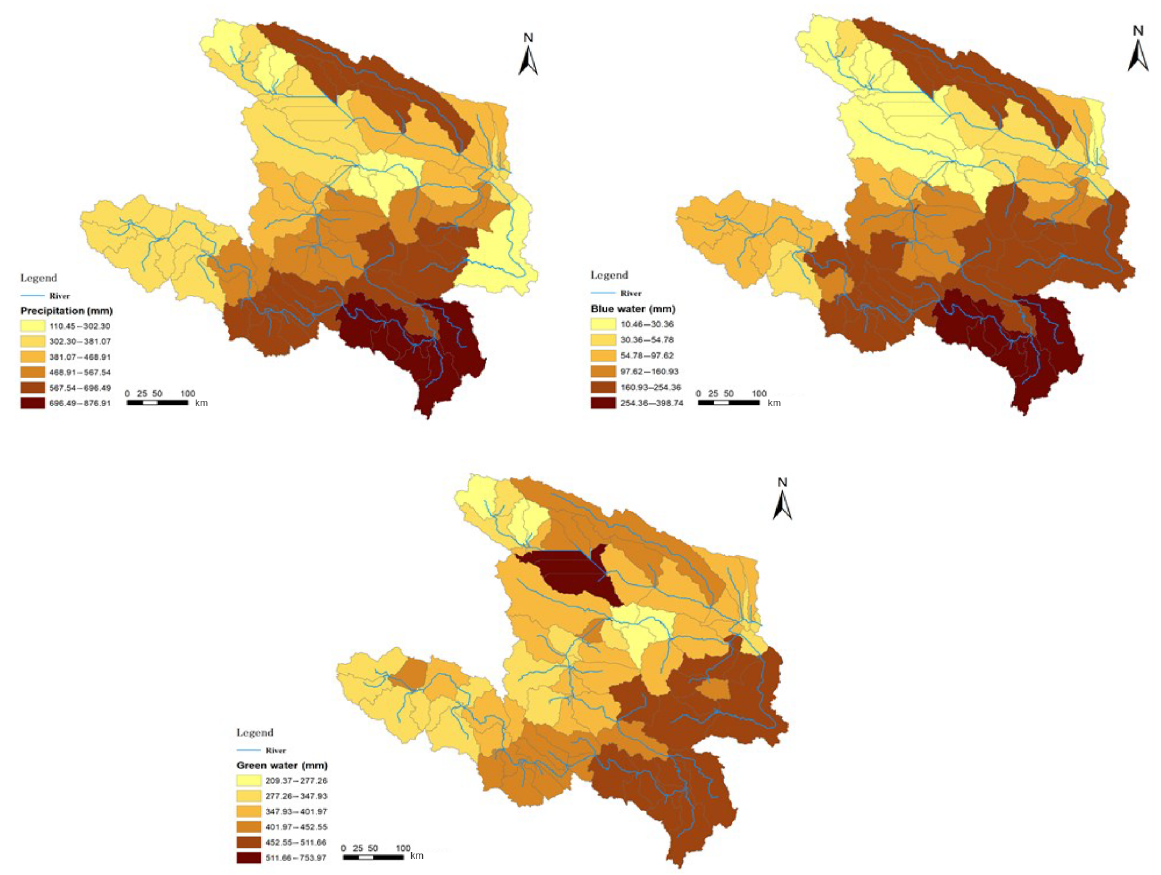
Figure 8. The spatial distribution of the precipitation and the blue and green